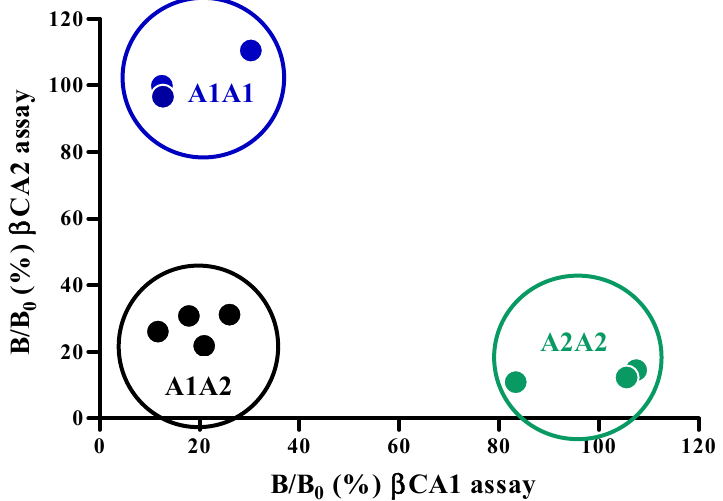
Figure 6. Phenotyping of raw milk samples collected from genotyped A1A1, A1A2 and A2A2 cows and pasteurized milk from supermarkets, by plotting the β CA1 and β CA2 responses against each other. Grouped in circles are the 3 phenotypes of milk tested, e.g., A1A1 milk ( • ), common milk A1A2 ( • ), and A2A2 milk ( • ).